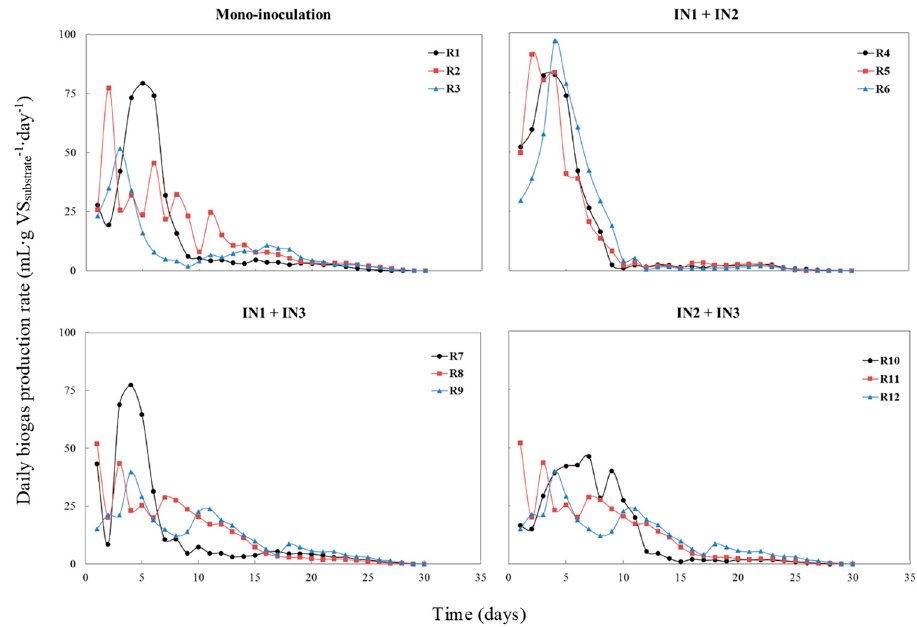
Figure 1. The daily biogas production for pressed fine sieved fraction (PFSF) inoculated with three different inoculums and their mixtures (IN1, digestate from the reactor treating the activated sludge; IN2, digestate from the reactor treating the organic fraction of MSW; and IN3, digested cow manure).